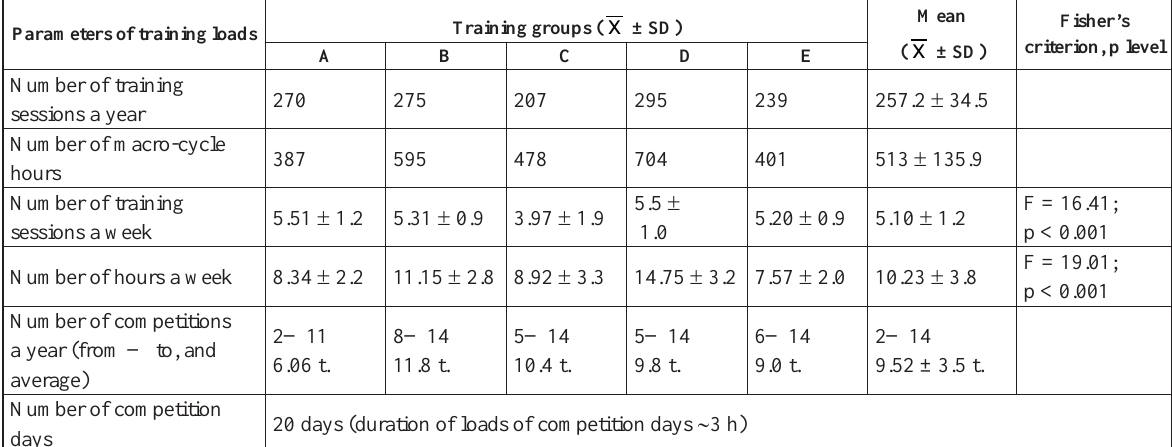
TRAINING AND SPORT PERFORMANCE OF THE 11—12 YEAR OLD ATHLETES IN RHYTHMIC Table 2. Training loads of different training programs of 11—12 year old athletes in rhythmic gymnastics